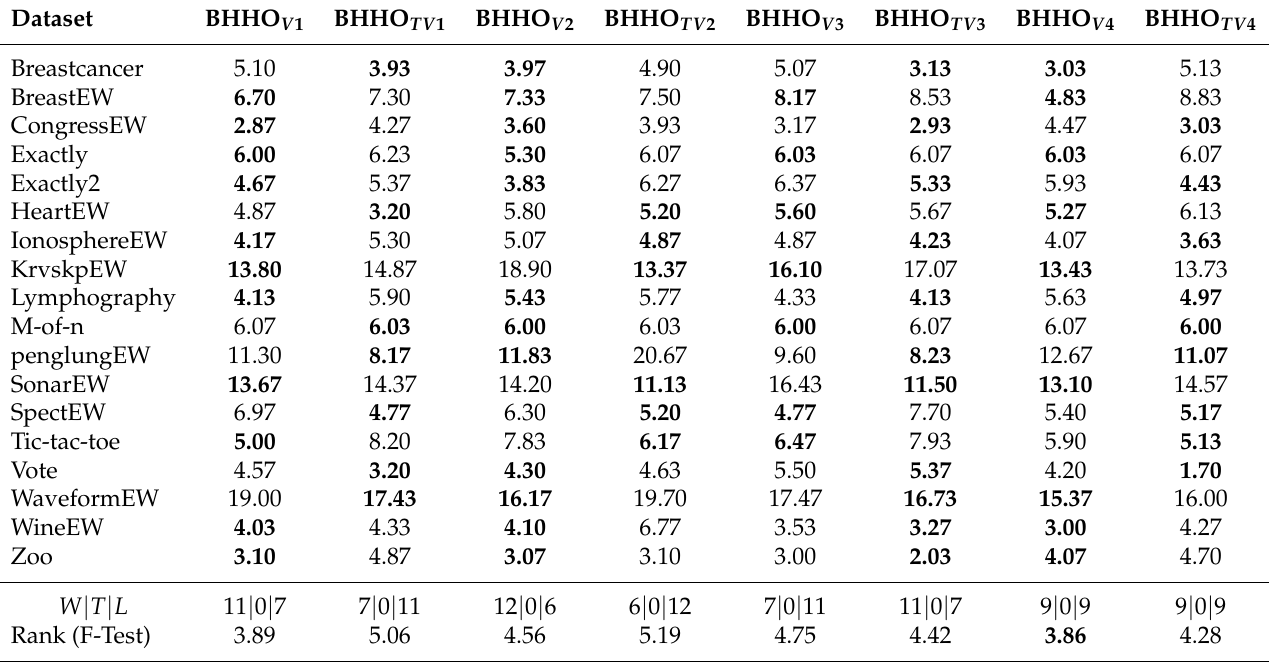
Table 5. Comparison of BHHO with the basic and time-varying V-shaped variants in terms of the number of selected features. Dataset